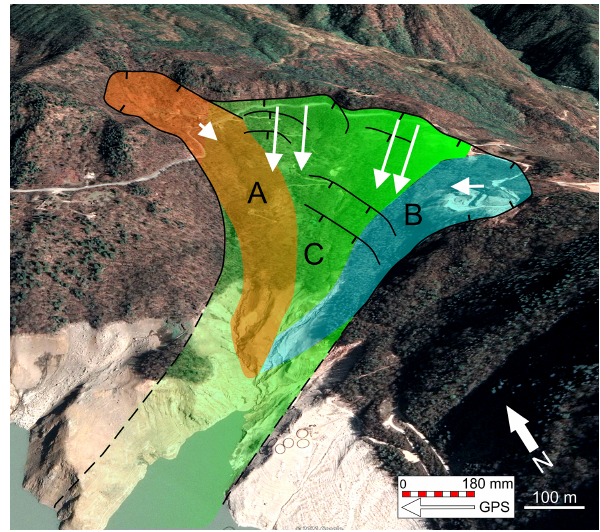
Figure 12. Sketch of the possible different units that compose the general landslide onshore. The green unit C corresponds to a deeper-seated slope deformation, whereas the orange (A) and the blue (B) units are shallower bodies. White arrows represent GPS vectors collected by Ospanov and Krivchenko (2021). Black lines are the main scarps affecting the slope (© Google Earth